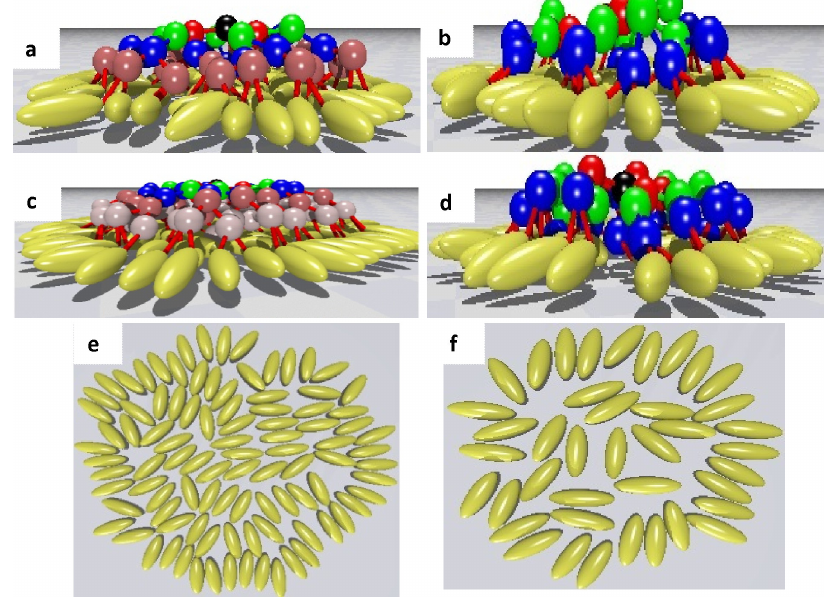
D D D D ; ( b ) G ; ( c ) G ; ( d ) G . In the bottom row, the junction 4 3 3 4 5 3 3 5 D D ; and ( f ) G 5 3 3 5